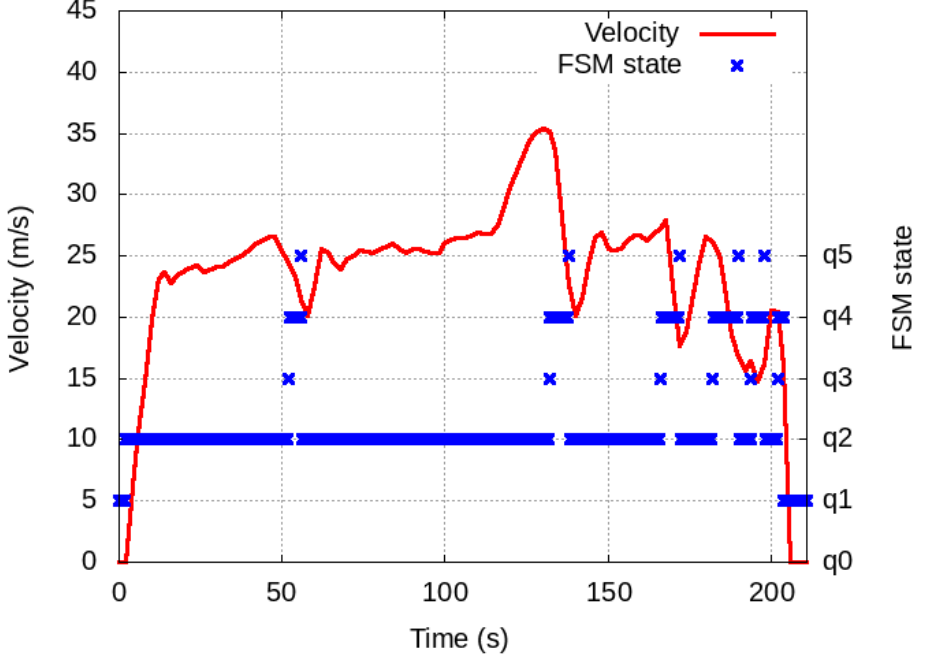
Figure 11. Velocity and FSM states diagram, created from data logged during the 3rd lap of the Shell Eco-marathon Europe